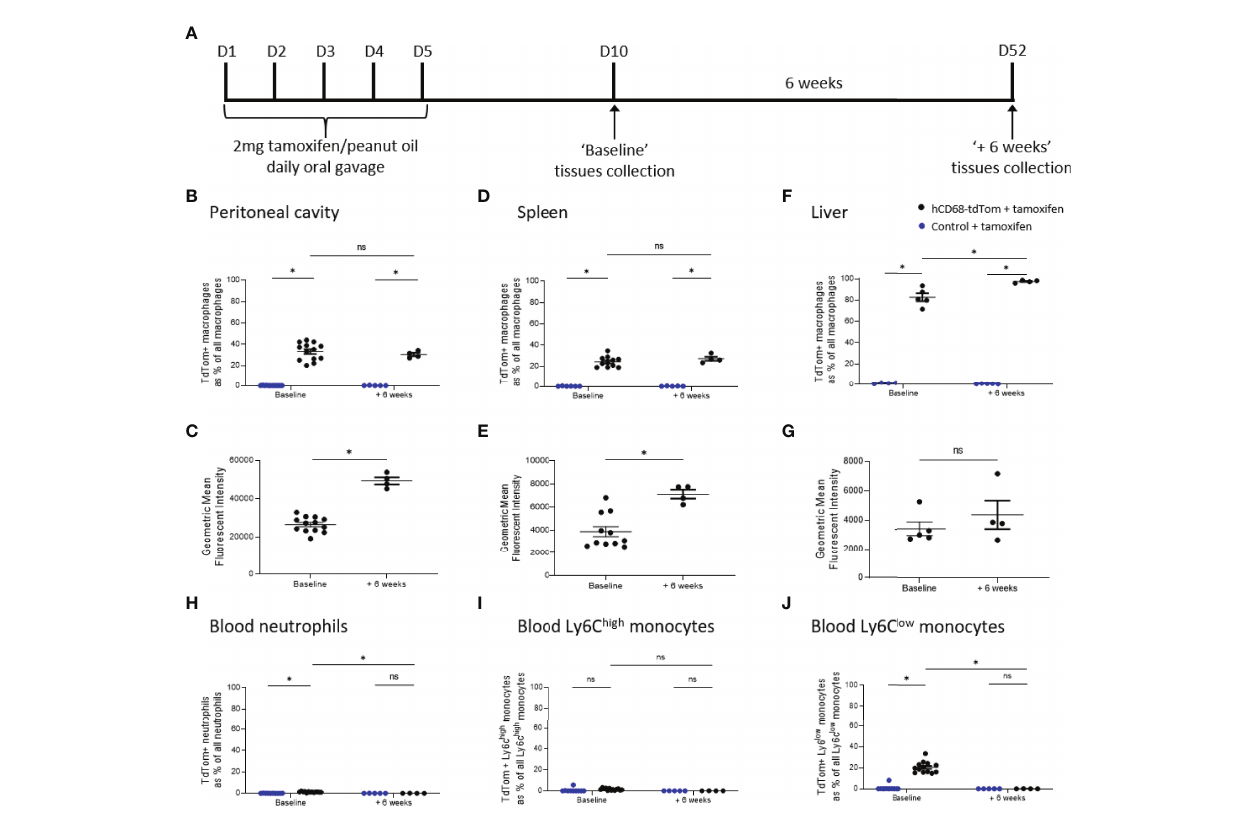
FIGURE 5 | TdTomato expression in tissue resident macrophages is maintained for at least 6 weeks after Cre recombinase activation. In panels (B, D, F, H – J) control + tamoxifen mice are marked as blue dots; hCD68-tdTom + tamoxifen mice are marked as black dots. In all panels mice with the usual 5 days wash out period are marked ‘ Baseline ’ , while mice with an additional 6 weeks wait are marked ‘ + 6 weeks ’ . (A) Tamoxifen dosing protocol for induction of Cre recombinase activity and assessment of targeting ef fi ciency 6 weeks post-induction in hCD68-CreERT2 model. Frequency of tdTomato-expressing macrophages as a proportion of all macrophages in (B) peritoneal cavity (D) spleen and (F) liver with corresponding mean fl uorescence intensity of tdTomato + macrophages for ‘ Baseline ’ and ‘ +6 weeks ’ groups in (C, E, G) . Frequency of tdTomato-expressing blood (H) neutrophils, (I) Ly6C high monocytes and (J) Ly6C low monocytes as a proportion of all blood leukocytes of the given type for ‘ Baseline ’ and ‘ +6 weeks ’ groups; two-way ANOVA in panels (B, D, F, H – J) , student t-test in panels (C, E, G) , (* = p < 0.05). ns, not signi fi